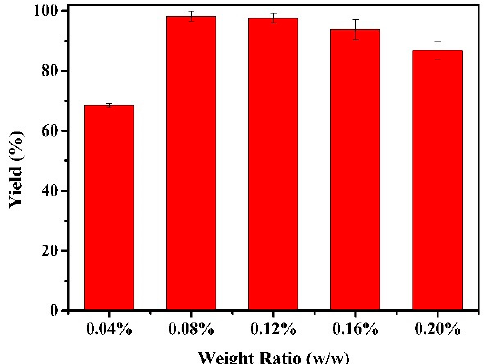
Figure 7. Effect of weight ratio (enzyme to nanoparticles) on activity of magnetic CALB CLEAs. Reactions performed with 5 mg magnetic CALB CLEAs and 2 mL of n-hexane containing 0.2 mmol of 2-phenylethanol and 0.4 mmol of vinyl acetate at 50 °C for 72 h.